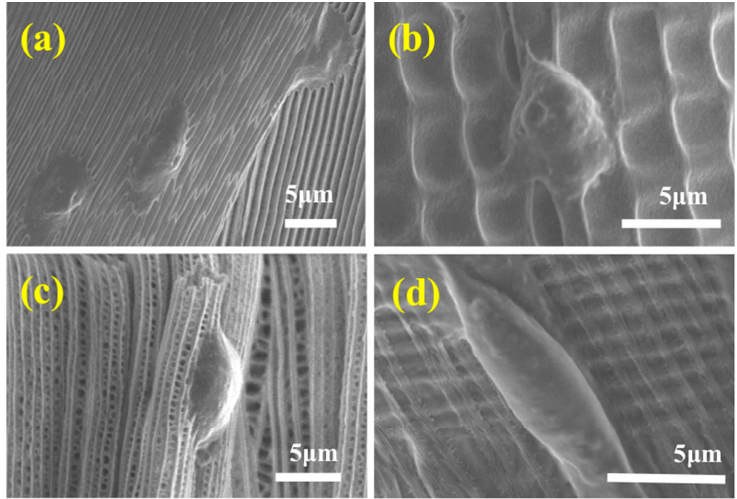
Figure 4. SEM images of NIH-3T3 fibroblast cells after 48 h cultured on the wing of ( a ) M. menelaus , ( b ) P. u. telegonus (blue region); ( c ) P. u. telegonus (fiber region), and ( d ) O. c. lydius wings .